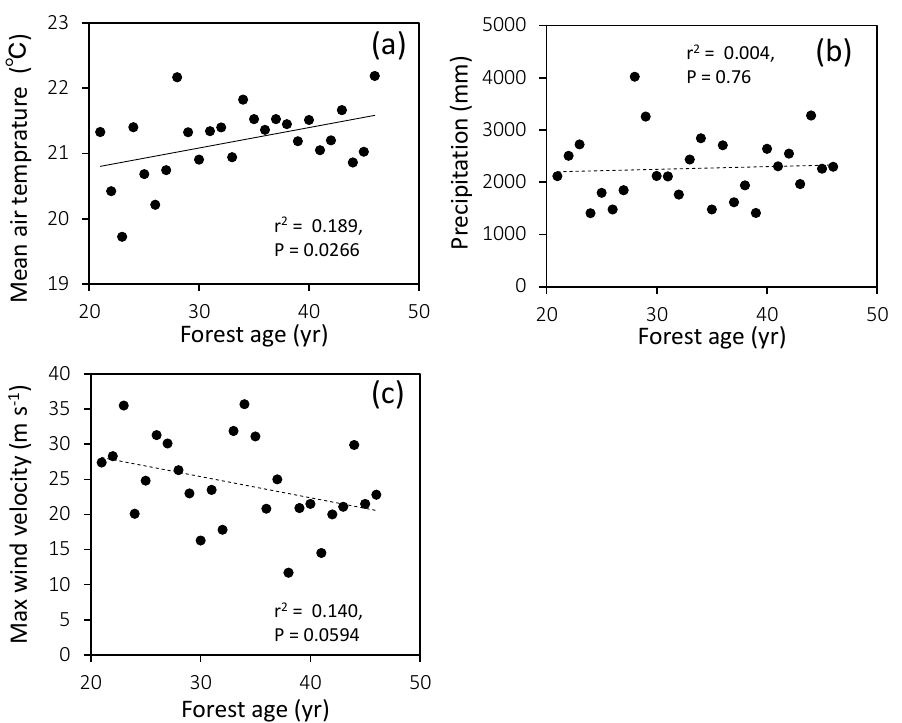
Figure 1. Mean air temperature ( a ) and precipitation ( b ) from March to October and maximum wind velocity from August to October ( c ) during the study period (1991–2016) at the Kochi Meteorological Station of Japan Meteorological Agency, located approximately 9 km east of the study site.